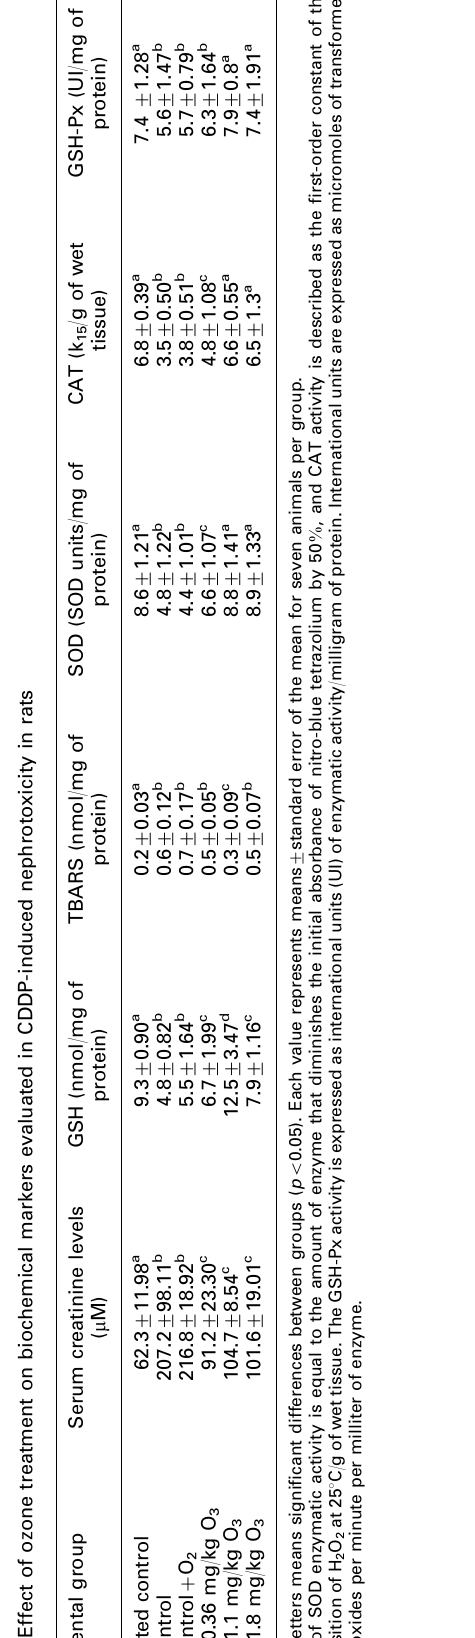
FIG. 2. Light micrograph of the corticomedulary region of a rat kidney treated with CDDP alone. Typical severe tubular necrosis with dilation of proximal tubules is shown. Arrows indicate dequamation of renal tubular cells and cast forma- tion in the tubular lumen (hematoxylin and eosin, (cid:4) / 400). T a